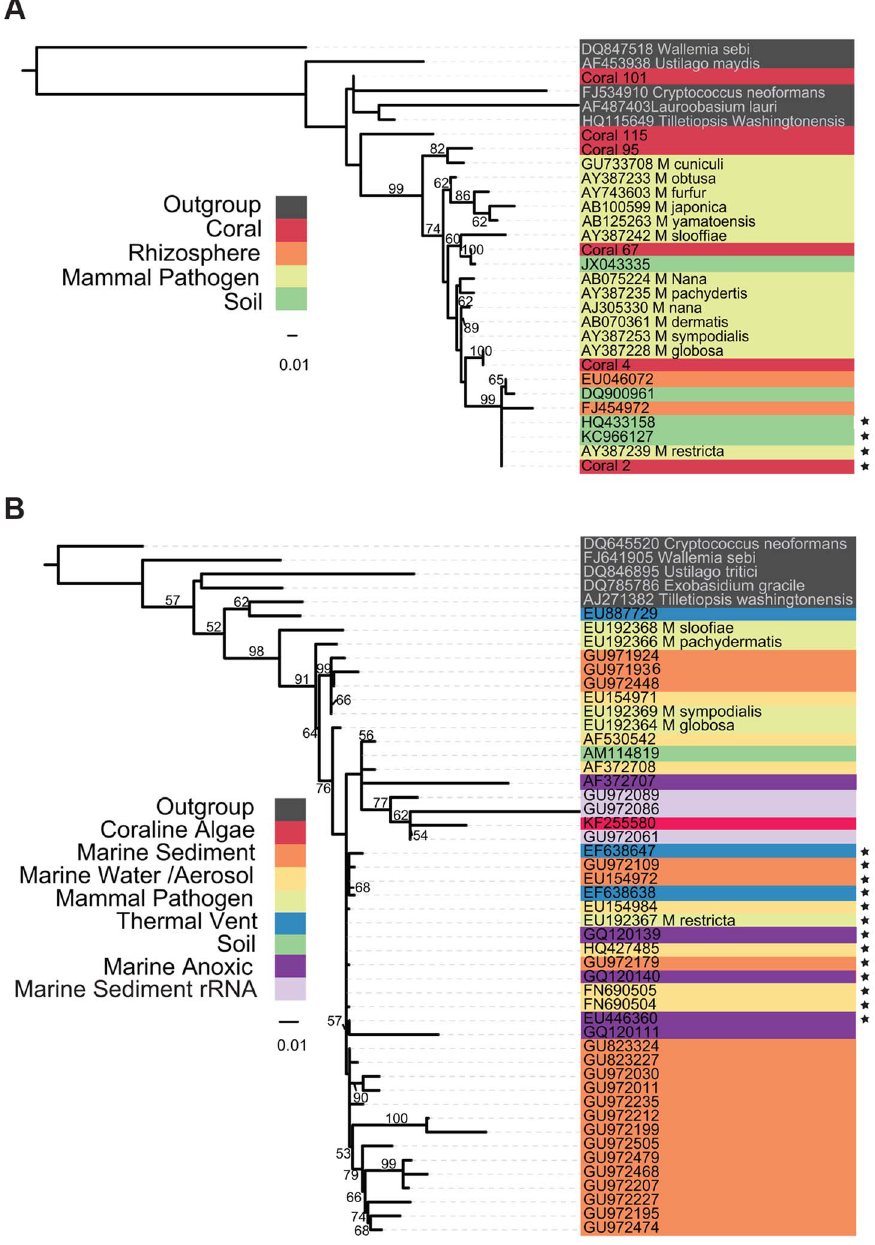
Figure 1. Phylogenetic Tree of Malassezia -like sequences derived from environmental DNA sequences and isolates. Tree topology was inferred using the best of 1,000 bootstrap replicates of a Maximum Likelihood tree building algorithm (RAxML). Bootstrap support values . 50% are indicated. Organism origin is indicated by highlight coloring. Sequences with 99% or greater identity to M. restricta are starred. (A) Tree containing sequences from the D1 and D2 variable domains of the large ribosomal subunit. Coral sequences are deposited in the NCBI SRA, accession # SRP005168. (B) Tree containing sequences spanning the V4 hypervariable region of the ribosomal small subunit; most sequences were compiled in [19].